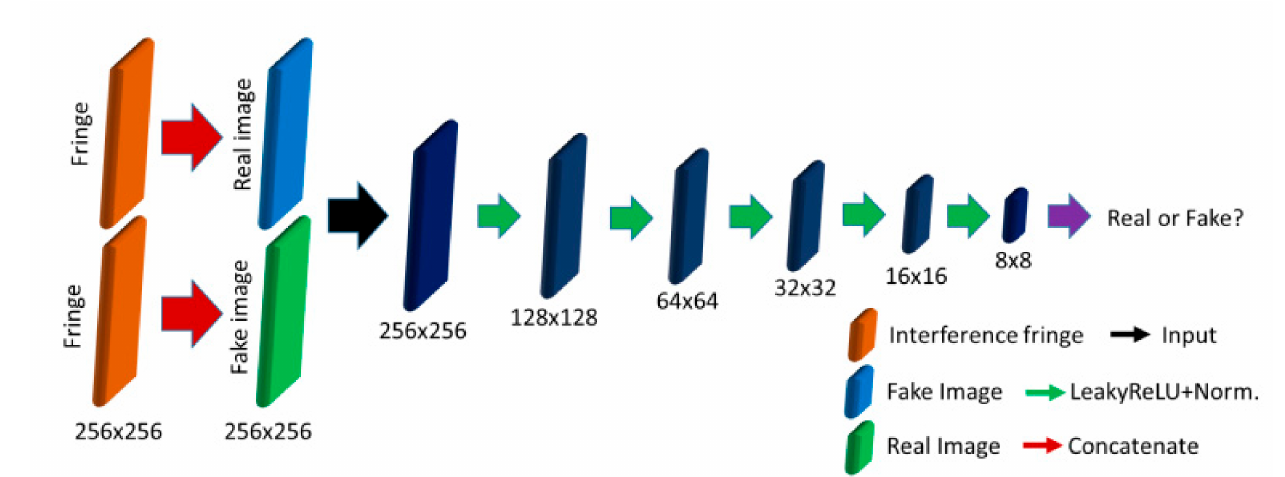
Figure 3. The architecture of the Discriminator network.